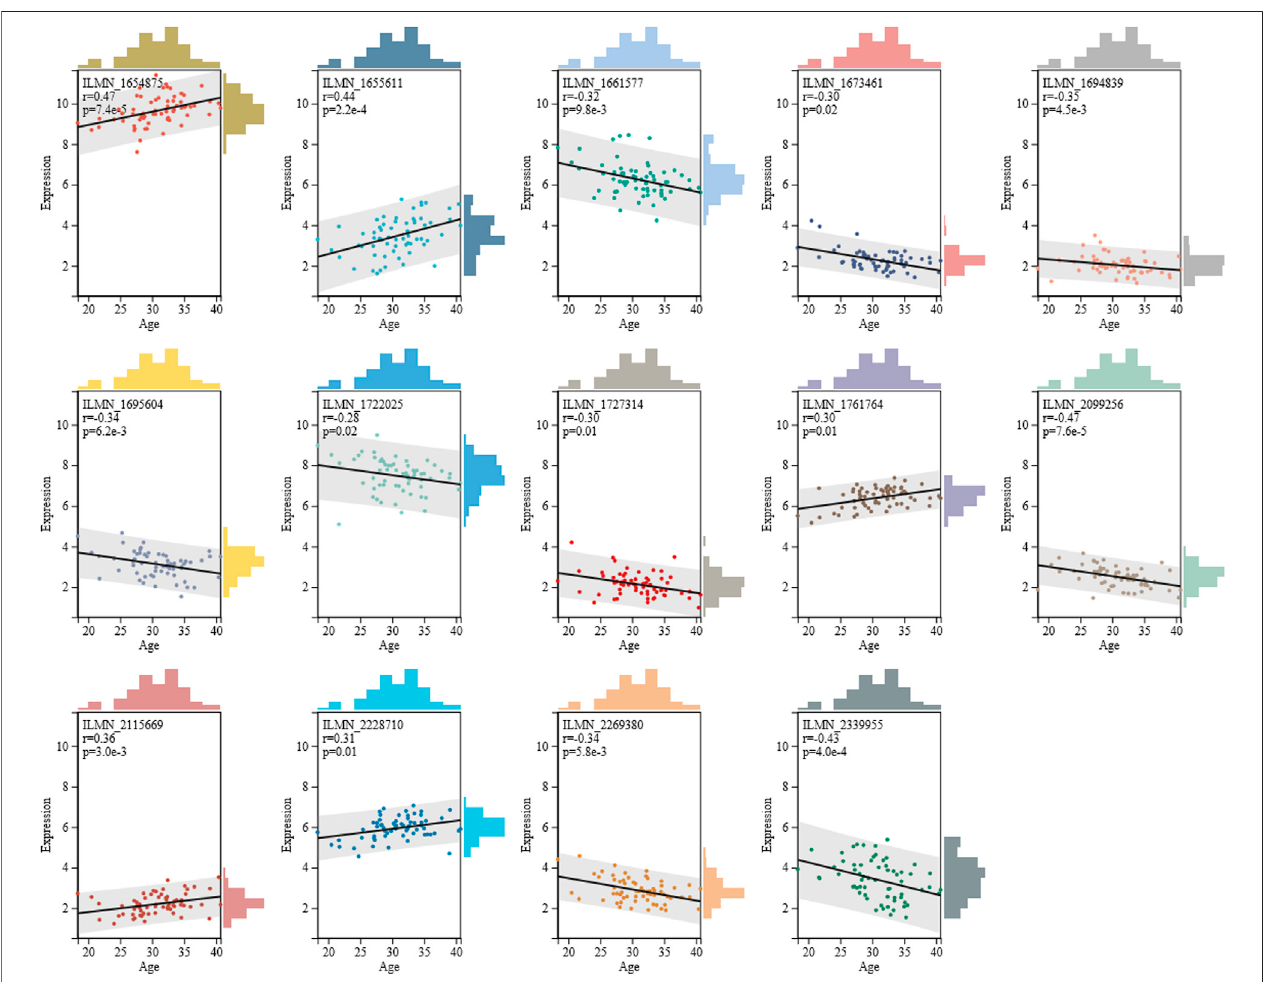
FIGURE 1 | Spearman correlation coef fi cient of 14 mRNAs with age. Detailed information of 14 mRNAs is given in Supplementary Table S5 .